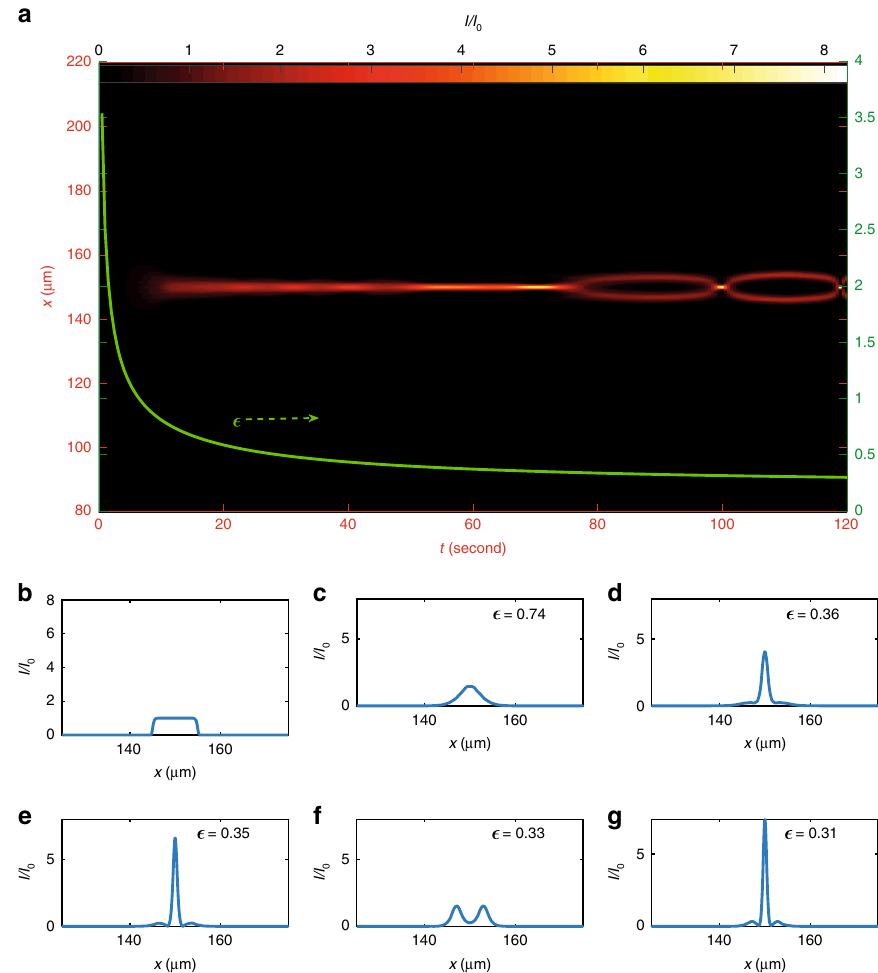
Fig. 4 Simulation of the topological control for a small waist. a Numerical simulation of the control of the fi nal state after a propagation distance ¼ 5 : 33 ´ 10 5 W/m 2 ). Axis t expresses time of detection, while x is the beam transverse L ¼ 2 : 5 mm for an initial beam waist W 0 ¼ 10 μ m ( I 0 ¼ P U 0 W 0 coordinate. b Initial beam intensity: a super-Gaussian wave centered at x ¼ 150 μ m. c – e Peregrine soliton generation: beam intensity ( c ) at t ¼ 12 s, and ( d ) at t ¼ 64 s, during the formation of the Peregrine soliton, while ( e ) exhibits the Peregrine soliton pro fi le at t ¼ 70 s. f , g Higher-order Peregrine soliton generation: beam intensity at f t ¼ 85 s, and g t ¼ 100 s, where the Peregrine soliton is alternately destroyed and